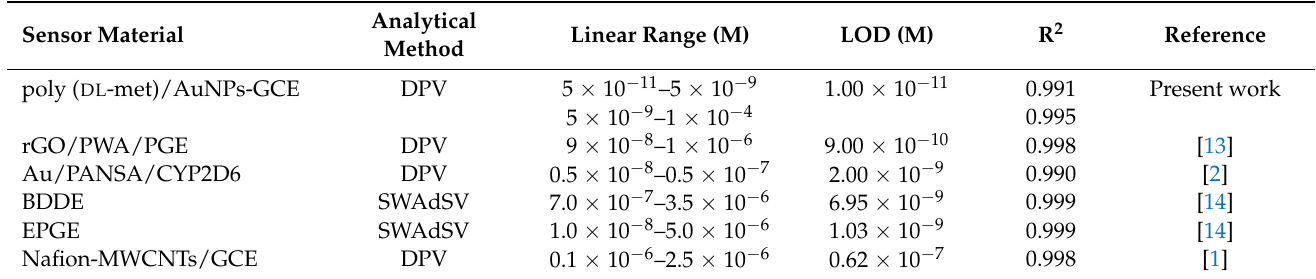
Table 1. Comparison between the present work and other previously reported electrochemical methods for PRX detection.